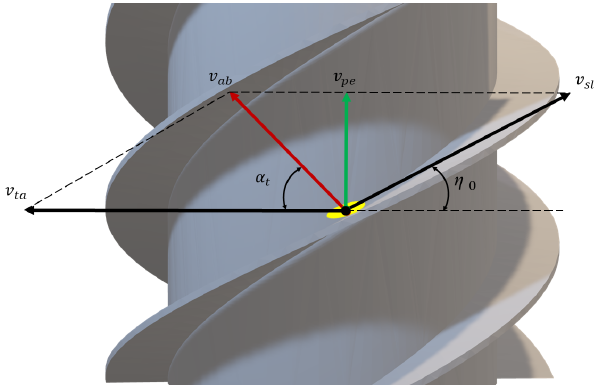
Figure 8. Relationship between the grain particle velocity and its